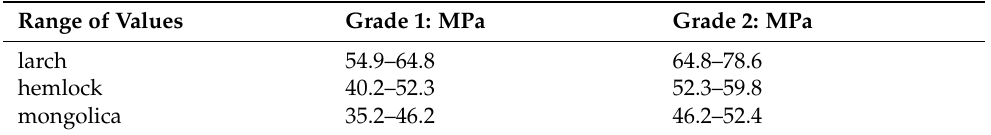
Table 6. Mechanical strength level classification.